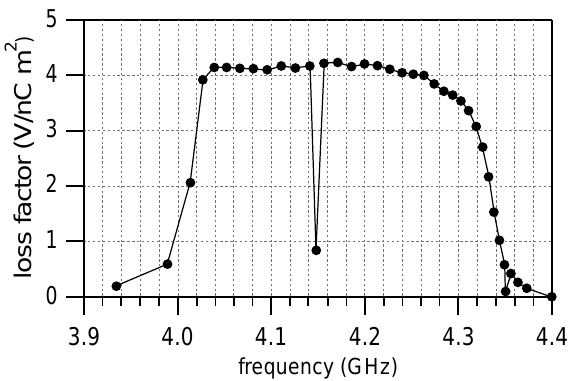
FIG. 5. Illustration of the test setup.